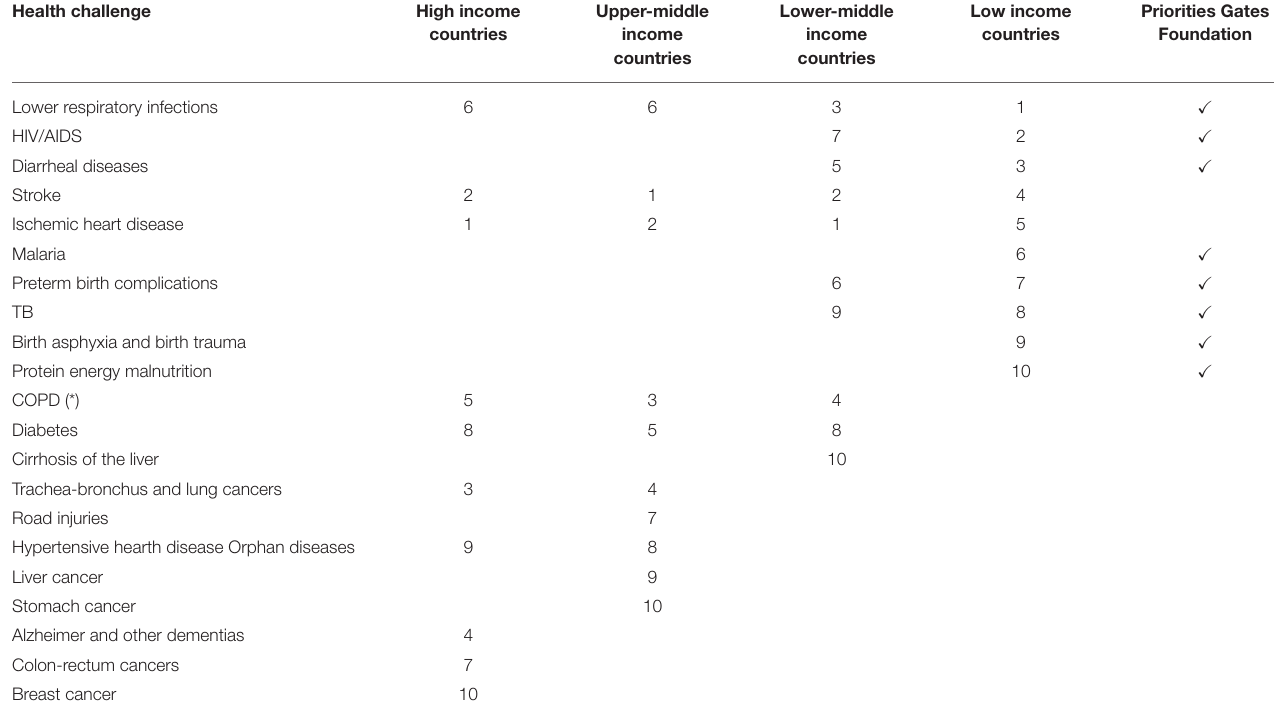
Upper-middle Lower-middle countries income income countries countries